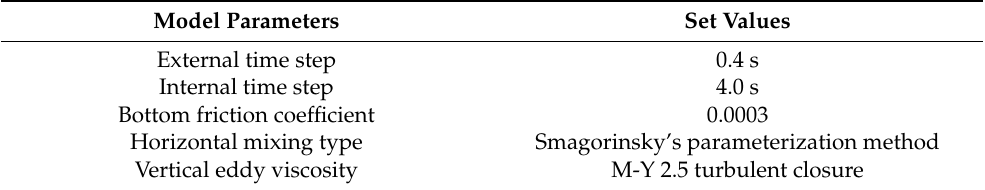
Table 1. Main parameters of model